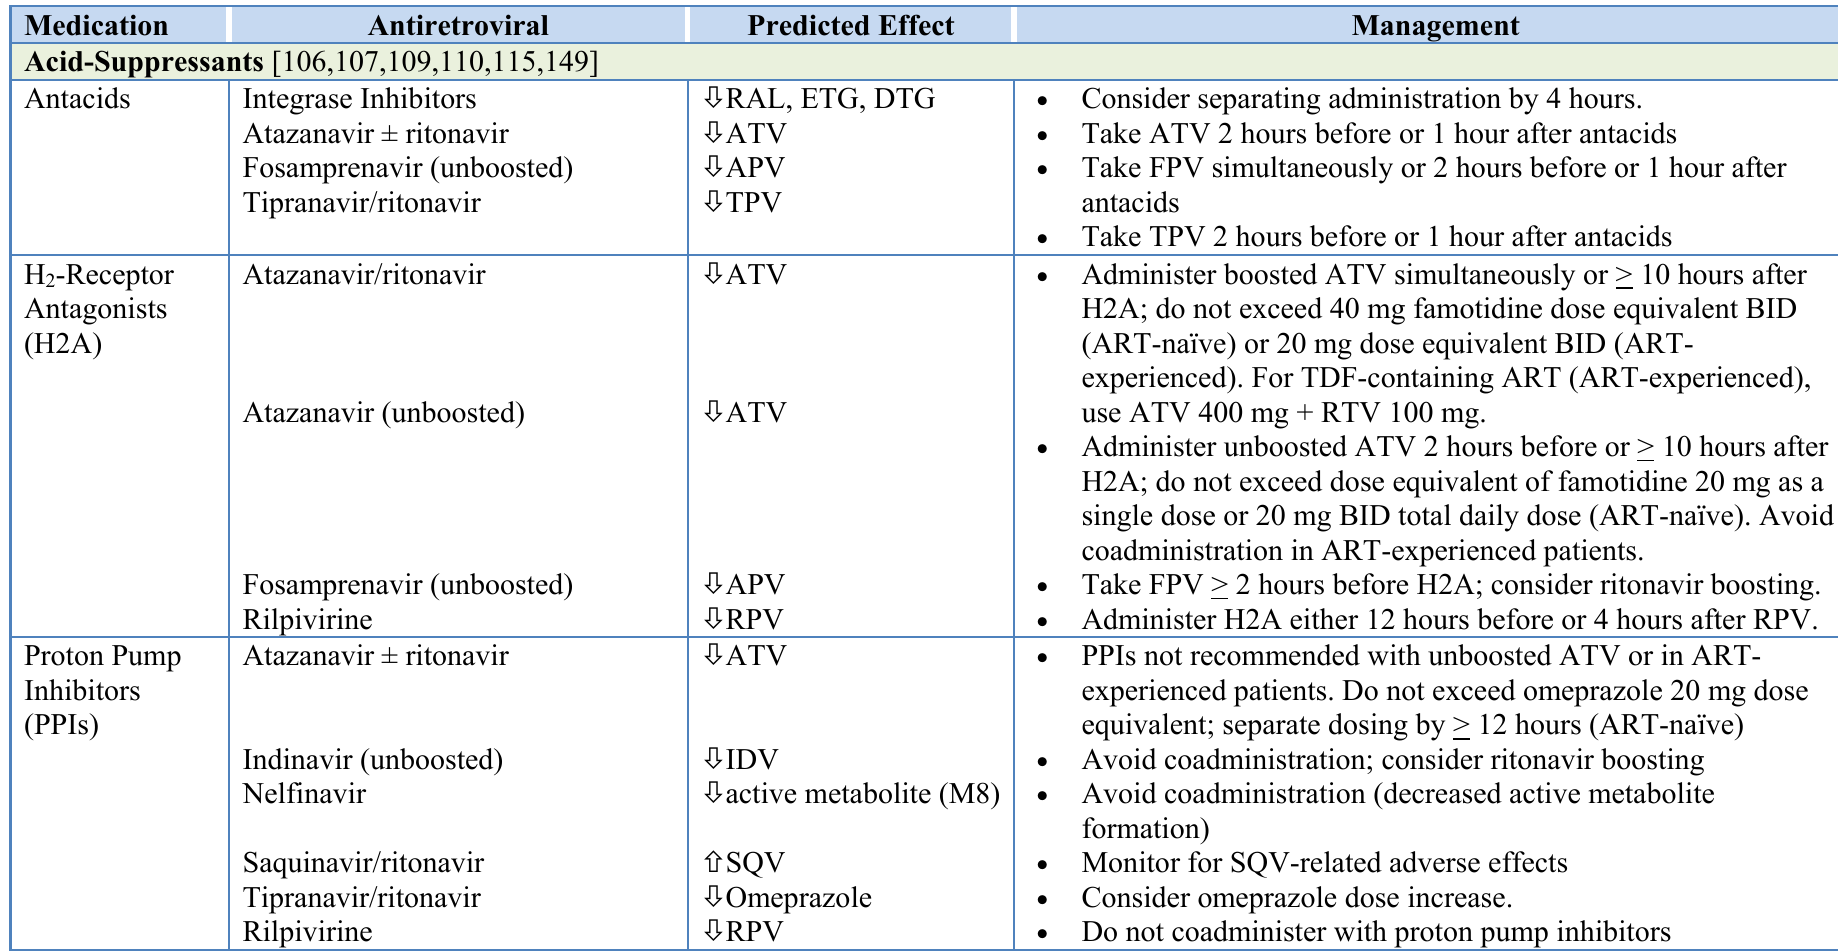
Table 2. Select antiretroviral drug interactions with medications for other comorbidities. Predicted Effect